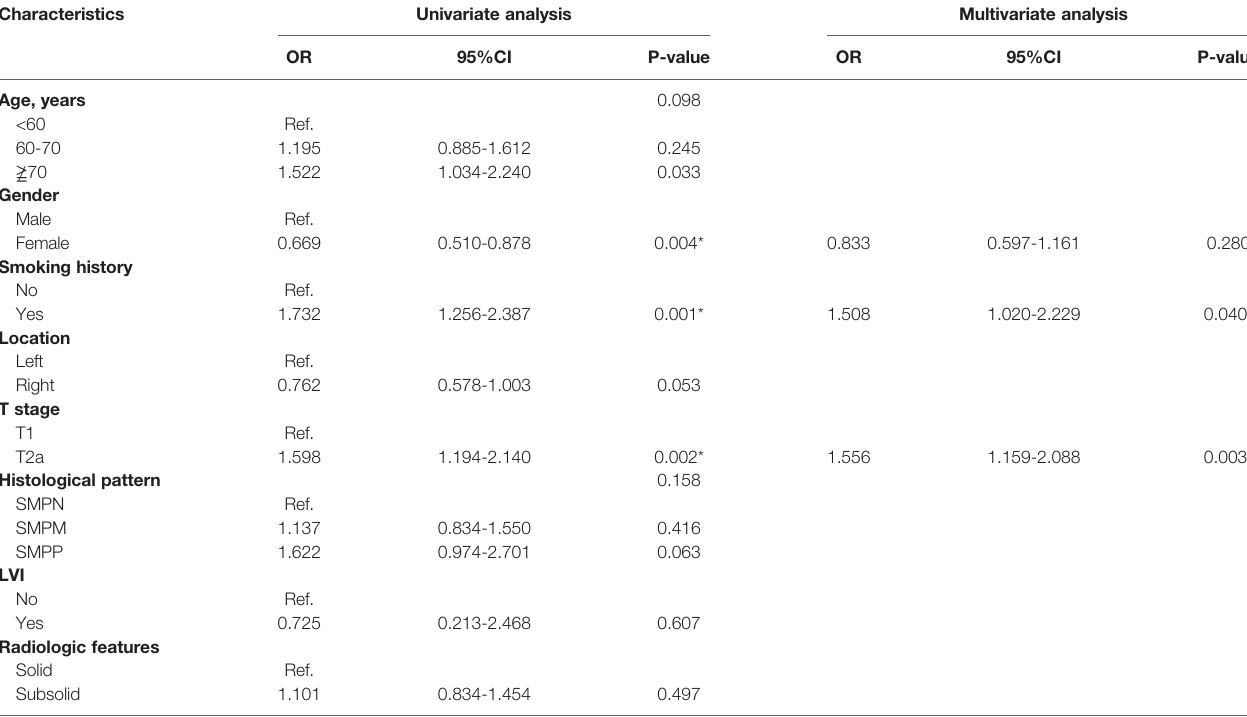
TABLE 2 | Univariate and multivariate logistic regression associating clinicopathologic variables with NLR.